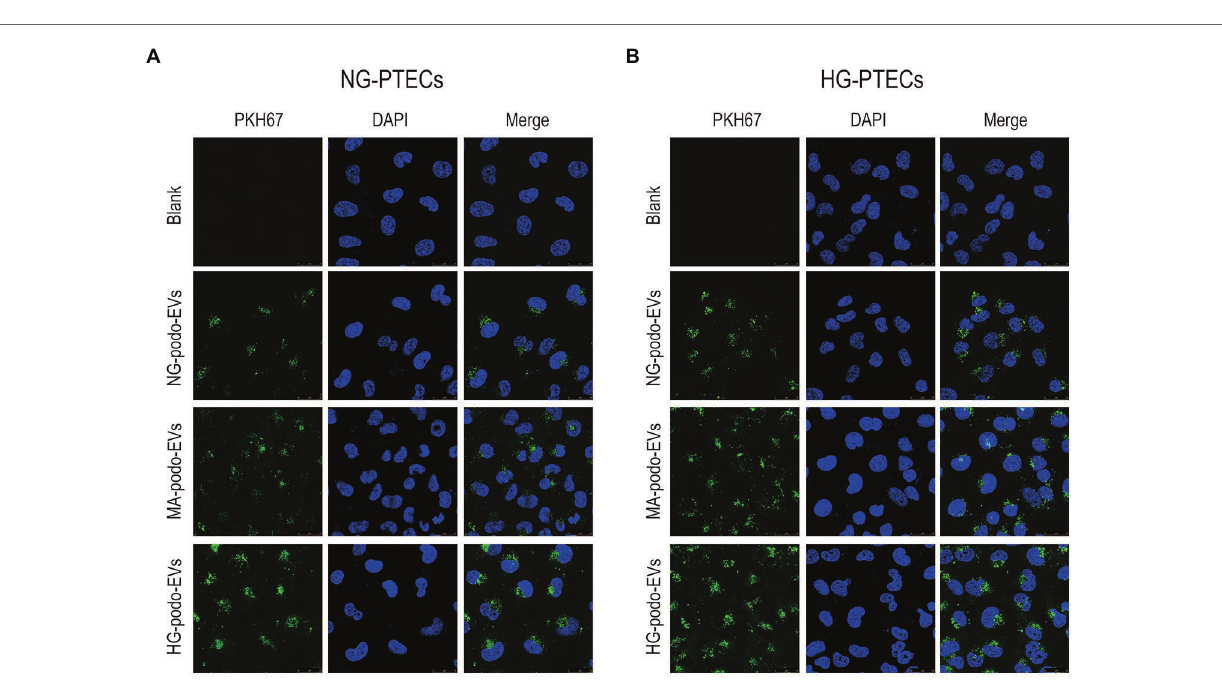
FIGURE 2 | EVs derived from NG/MA/HG-treated podocytes were internalized by cultured PTECs. EVs were labeled with PKH67. Scale bar, 25 μ m. (A) EVs from podocytes were added to NG-treated PTECs. (B) EVs from podocytes were added to HG-treated PTECs. HG, high glucose; MA, mannitol; NG, normal glucose; podo, podocytes; PTECs, proximal tubular epithelial